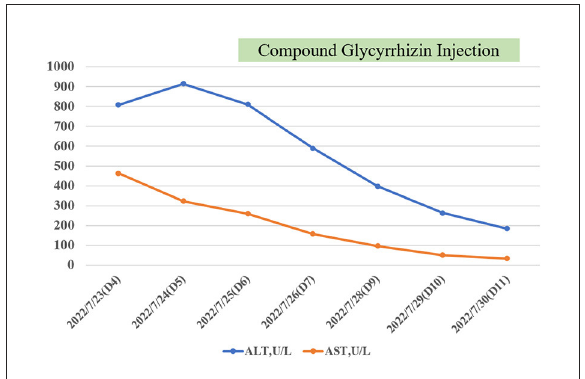
FIGURE1 The trend of transaminase. With the use of compound glycyrrhizin injection (CGI), the patient gradually recovered from acute liver